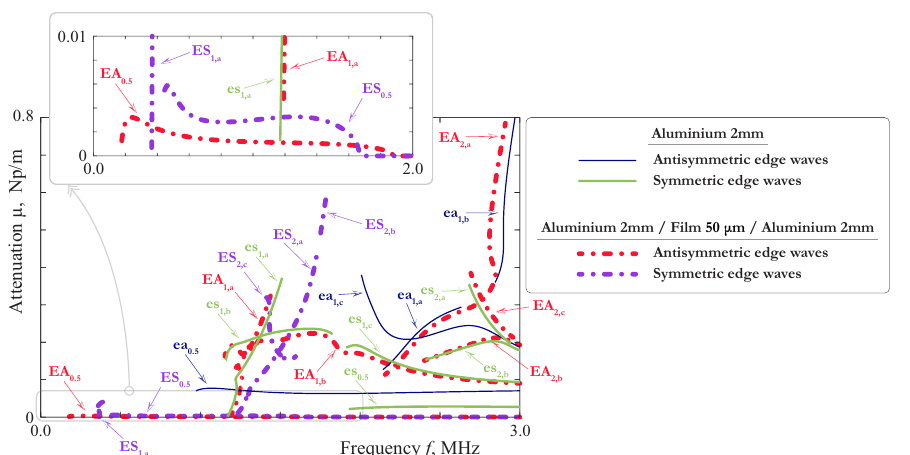
Figure 16. Attenuation of EWs propagating in 4.05 mm thickness symmetric laminate with a soft thin interlayer (2 mm aluminium/50 µ m film/2 mm aluminium) and 2 mm aluminium